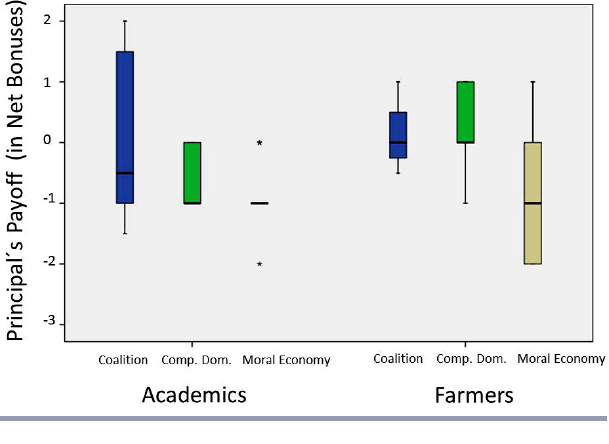
Fig. 5 . Distribution of observed principals’ payoffs in net bonuses (NB) across three social preferences and across two actors, academics and farmers. Net bonuses frequency distributions are compared graphically with box and whiskers quartiles. See X² comparisons in the main text.